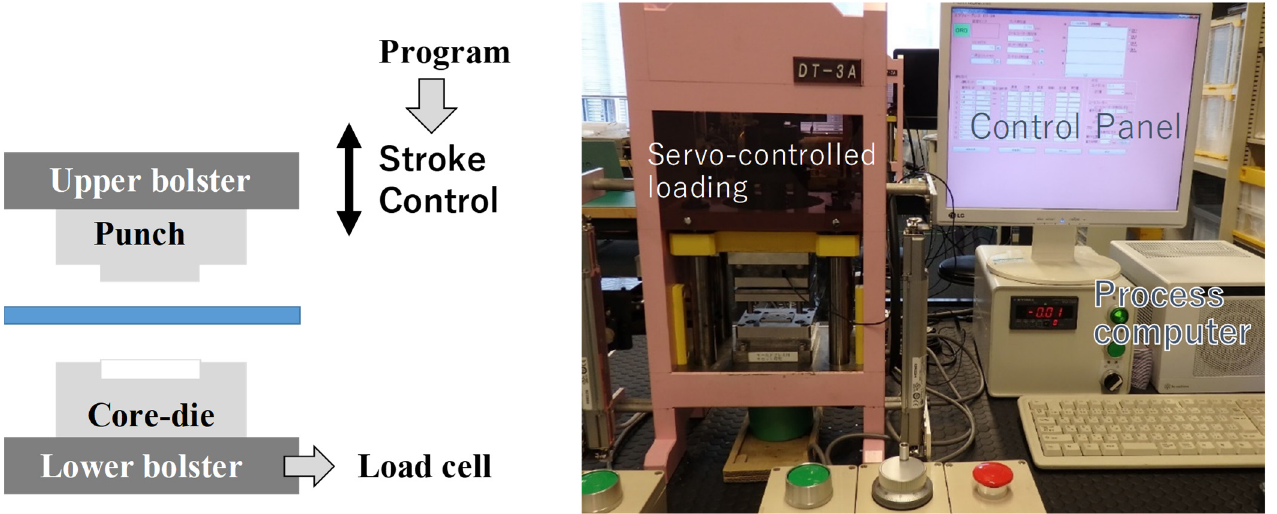
Figure 3. Schematic view and photo of the experimental setup with the use of CNC stamping system for piercing electrical steel sheets with a thickness of 0.2 mm with the use of plasma-printed punch and die.